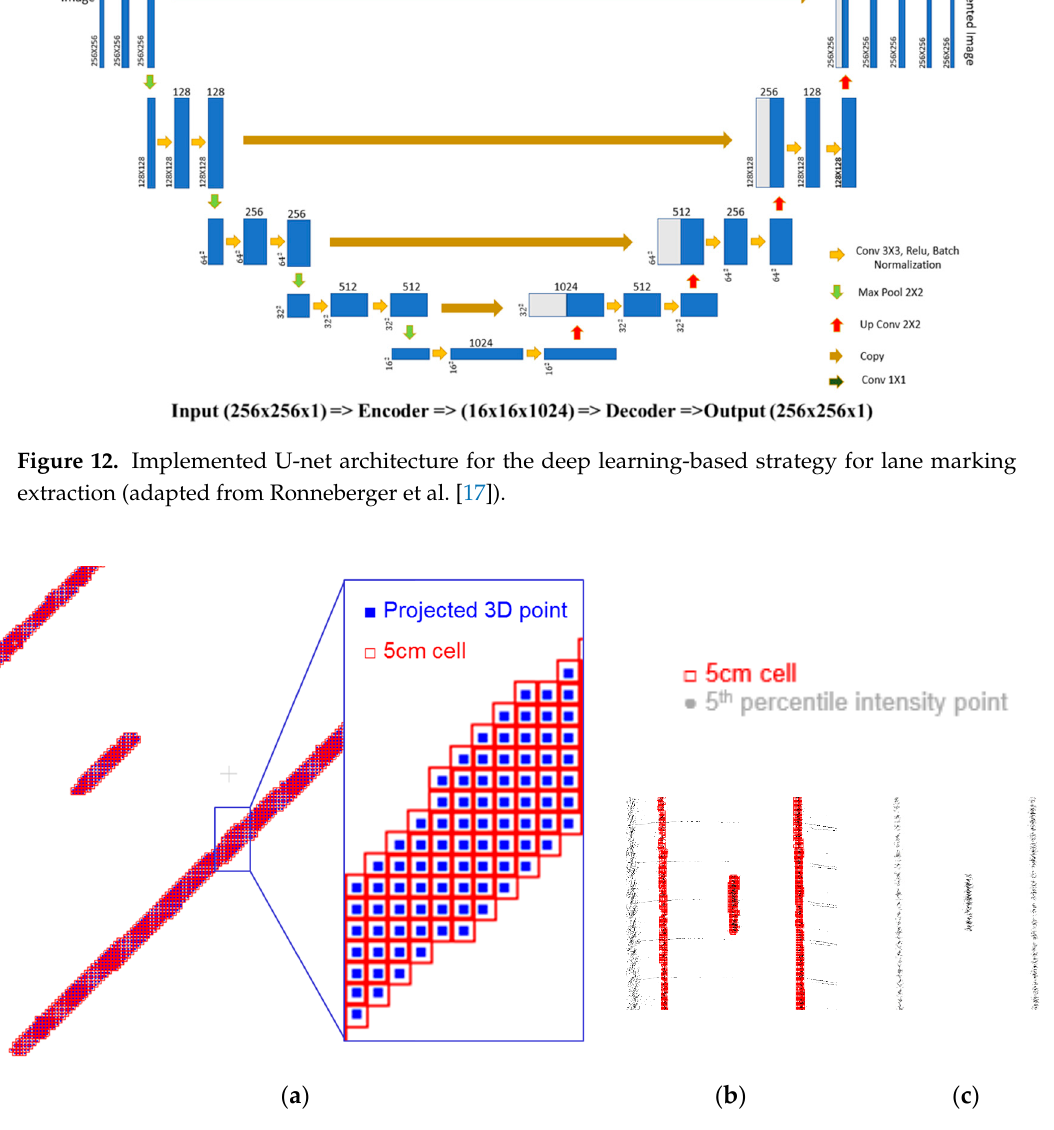
Figure 14. Lane marking centerline derivation framework (adapted from Ravi et al. [18]). First, a distance-based region growing is applied to the hypothesized lane marking points. If the distance between two lane marking points is less than a distance threshold ( Th dist ), they are grouped into the same cluster. This Th dist is defined based on LPS analysis of the road surface point cloud.